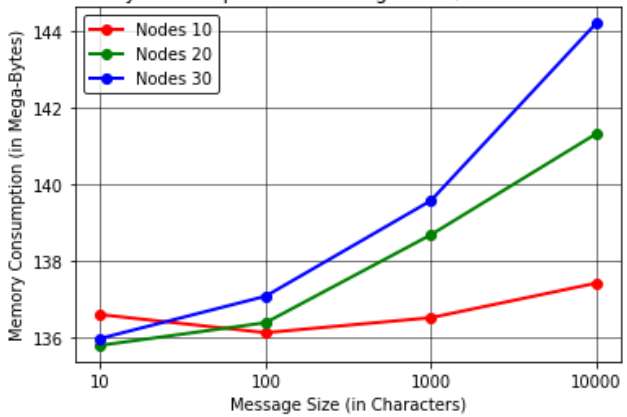
Figure 7. Memory consumption vs. message